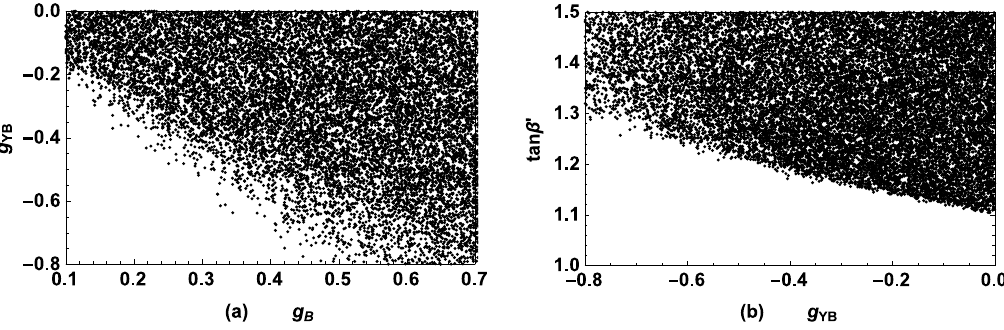
Figure 4 . Scanning the parameters in eq. (3.6) and considering the constraints from the observed Higgs boson mass, the Higgs boson decays, ¯ B → X s γ and the bound from the LHC searches on chargino/neutralino mass, we plot the allowed ranges of tan β 0 , g